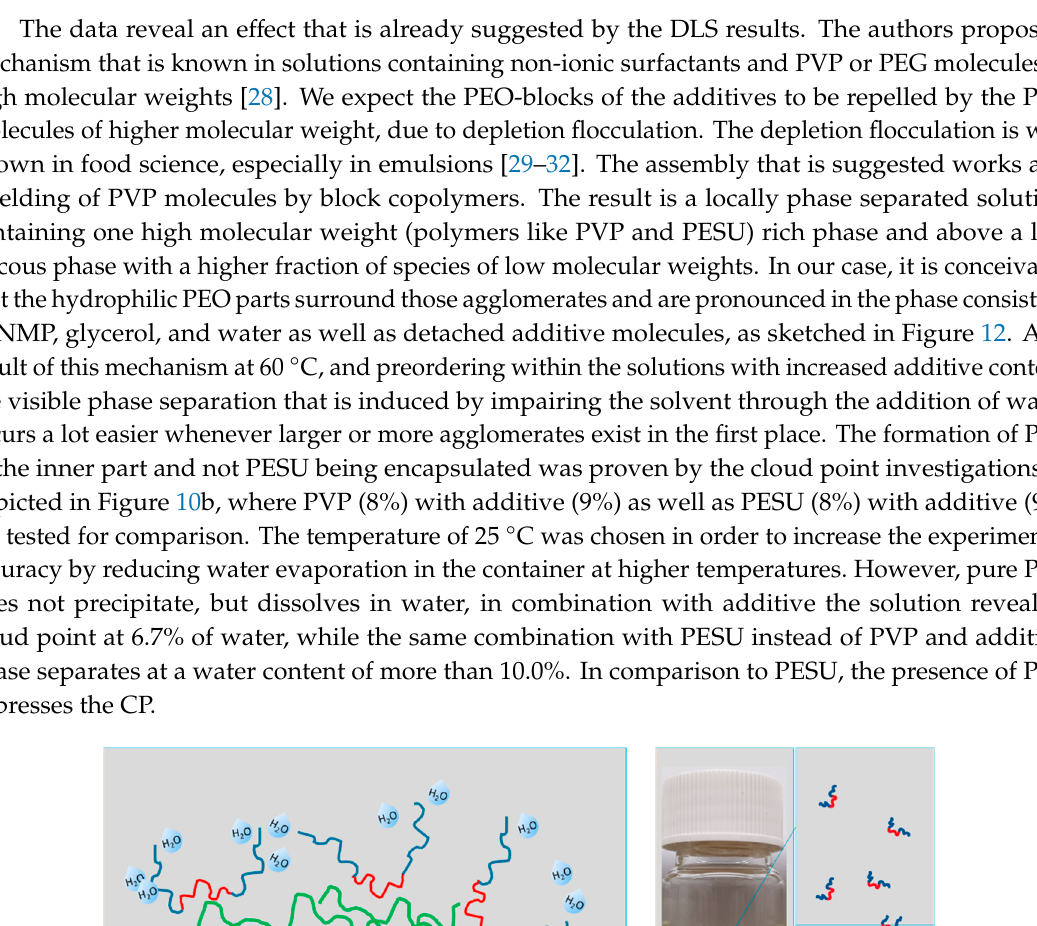
Figure 11. ( a ) Photograph of additive solutions AS 0 to AS 12 at room temperature. ( b ) All solutions after CP measurements. The solutions were not stirred for 24 h until the polymer rich phase (lower) macroscopically separated from the phase with low molecular weight species.